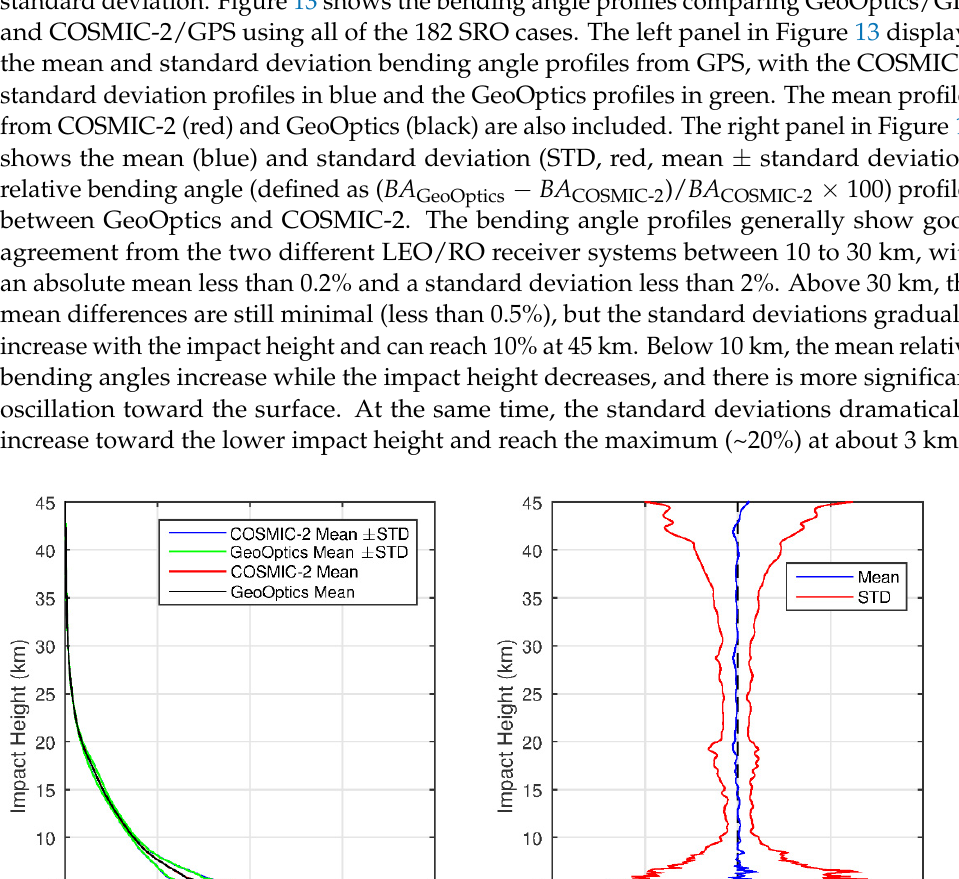
Figure 14. This figure is the same as Figure 13, but for GLONASS satellites over a total of 107 SRO cases.